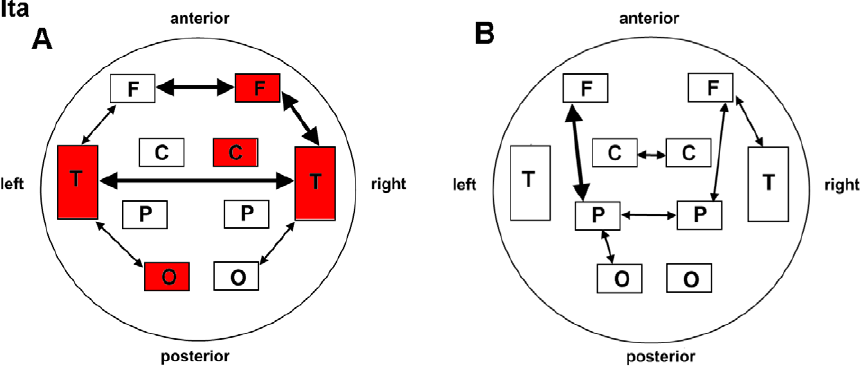
Figure 3. Schematic illustration of BLP correlation alterations for the delta band. A. ST36 group. B. NAP group. Lines correspond to significant changes for the average Band-Limited Power (BLP) correlation induced by acupuncture and squares to significant change in the local BLP correlation (red: local increase in the BLP correlation following acupuncture; thin line: P , 0.05; thick line: P , 0.01; significance is based upon a paired t - test).